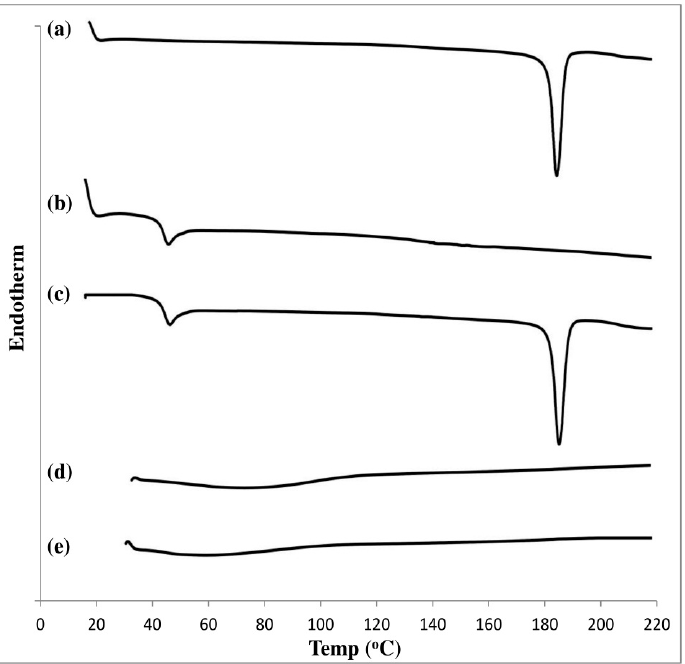
Figure 10. DSC thermograms of ( a ) pure alogliptin ( b ) PLGA ( c ) physical mixture ( d ) blank ISGI formulation ( e ) optimized ISGI formulation. formulation ( e ) optimized ISGI